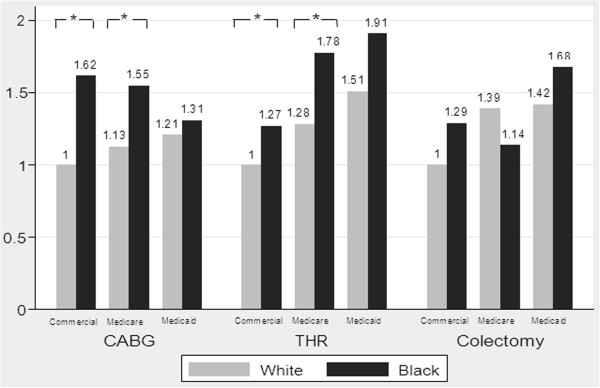
Impact of patient insurance on racial disparities in the use of blood transfusion in major surgery. AOR: Adjusted odds ratio; *p<0.05 for pairwise comparison with identical insurance coverage. This figure is based on the risk adjusted models controlling for patient-level factors (age, gender, admission status, APR-DRG severity of illness, and AHRQ comorbidities) and full interaction terms between race (black vs. white) and patient insurance.